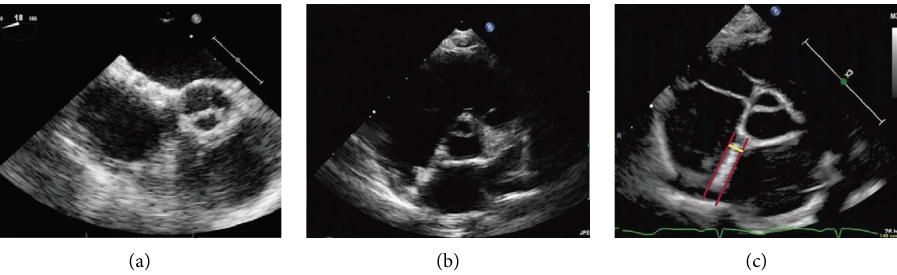
Figure 2: Short-axis view showing the visibility of the implanted CBSO occluder during implantation (on TOE), at 6 months follow-up (on TTE), and at 12 months follow-up (on TTE). Te site of measurement of a septal thickness (yellow line) is shown in the image on the right.